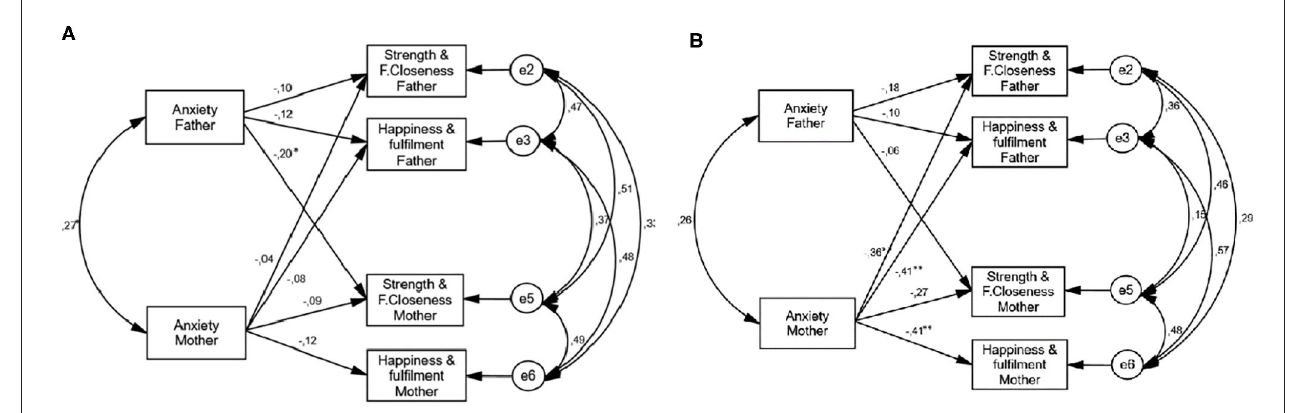
FIGURE 3 | Multigroup parental anxiety model. (A) Mild moderate ASD group. (B) Severe ASD group. * p < 0.05; ** p < 0.01.